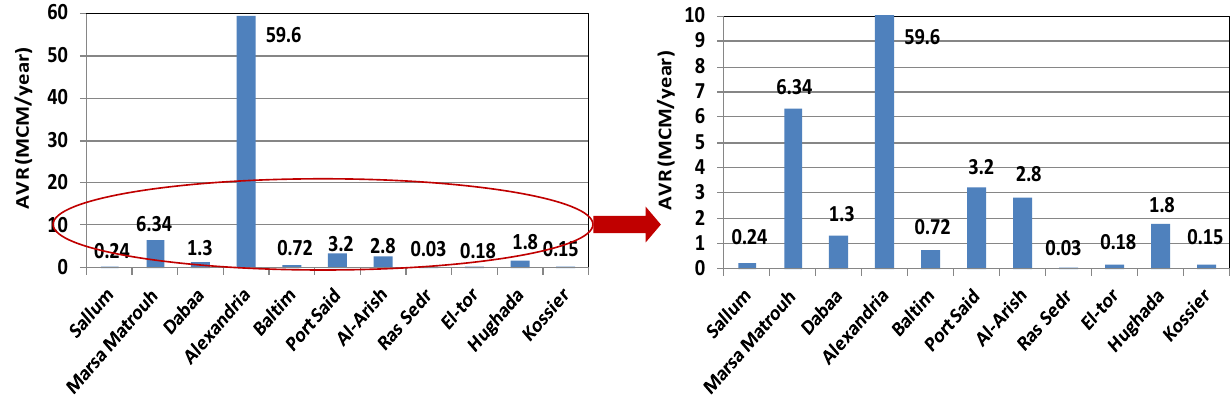
Fig. 9 Volumes of the annual RWH from some selected Egyptian coastal